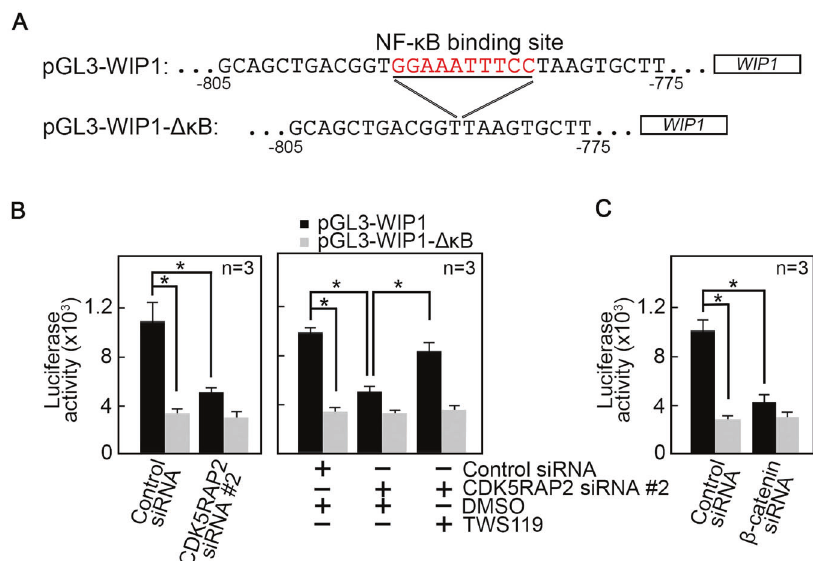
Fig. 8 CDK5RAP2 regulates WIP1 promoter activity via β -catenin. A Sequence of pGL3 luciferase reporter vector carrying WIP1 or WIP1- Δκ B promoter. B , C Loss of CDK5RAP2 ( B left and right panels) or β -catenin ( C ) inhibits WIP1 promoter activity as measured by luciferase reporter activity but inhibition of GSK3 β with TWS119 (5 μ M in DMSO) in CDK5RAP2-depleted cells restores WIP1 promoter activity ( B , right panel). Data represent means ± SD from three ( n = 3) independent experiments. * p <